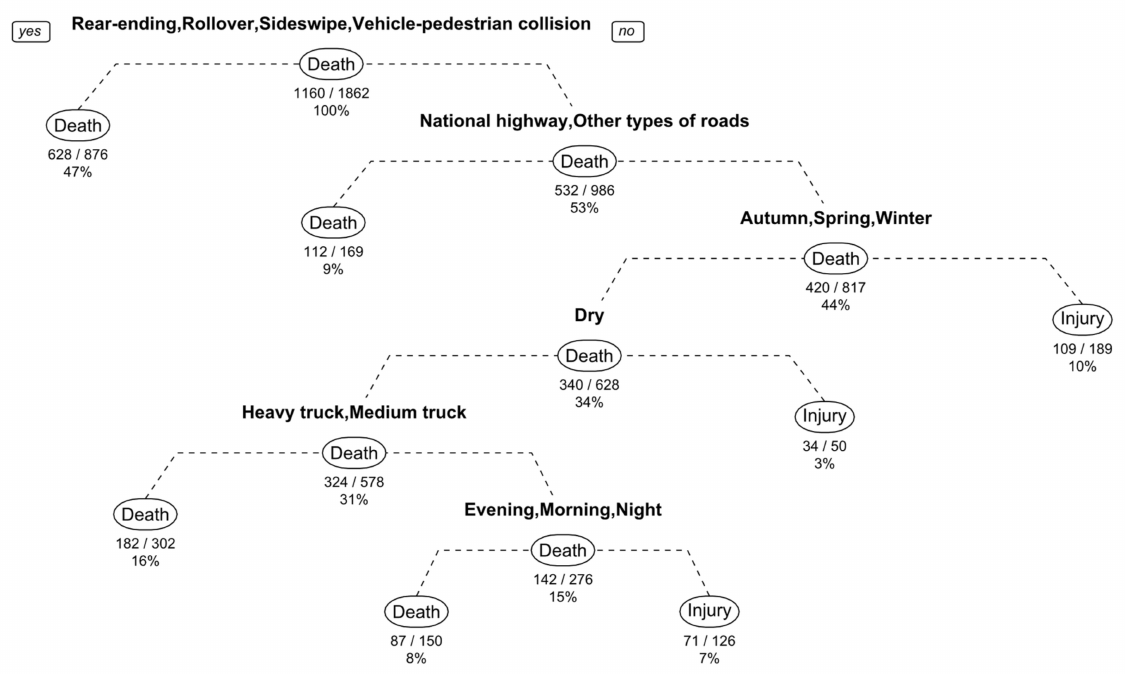
Figure 1. Decision tree built by CART. Note. a/b = the number of “yes” feedback/the number of